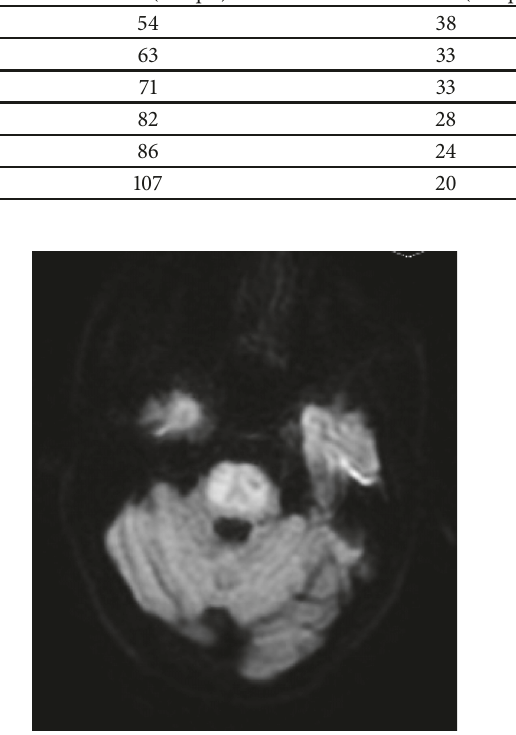
Figure1:MagneticResonanceImagingofthebrainwithoutcontrast showed high T2 signal and low T1 signal with restricted diffusion along with sparing of the bilateralperipheral pons, classicfor central intrapontine, and extrapontine